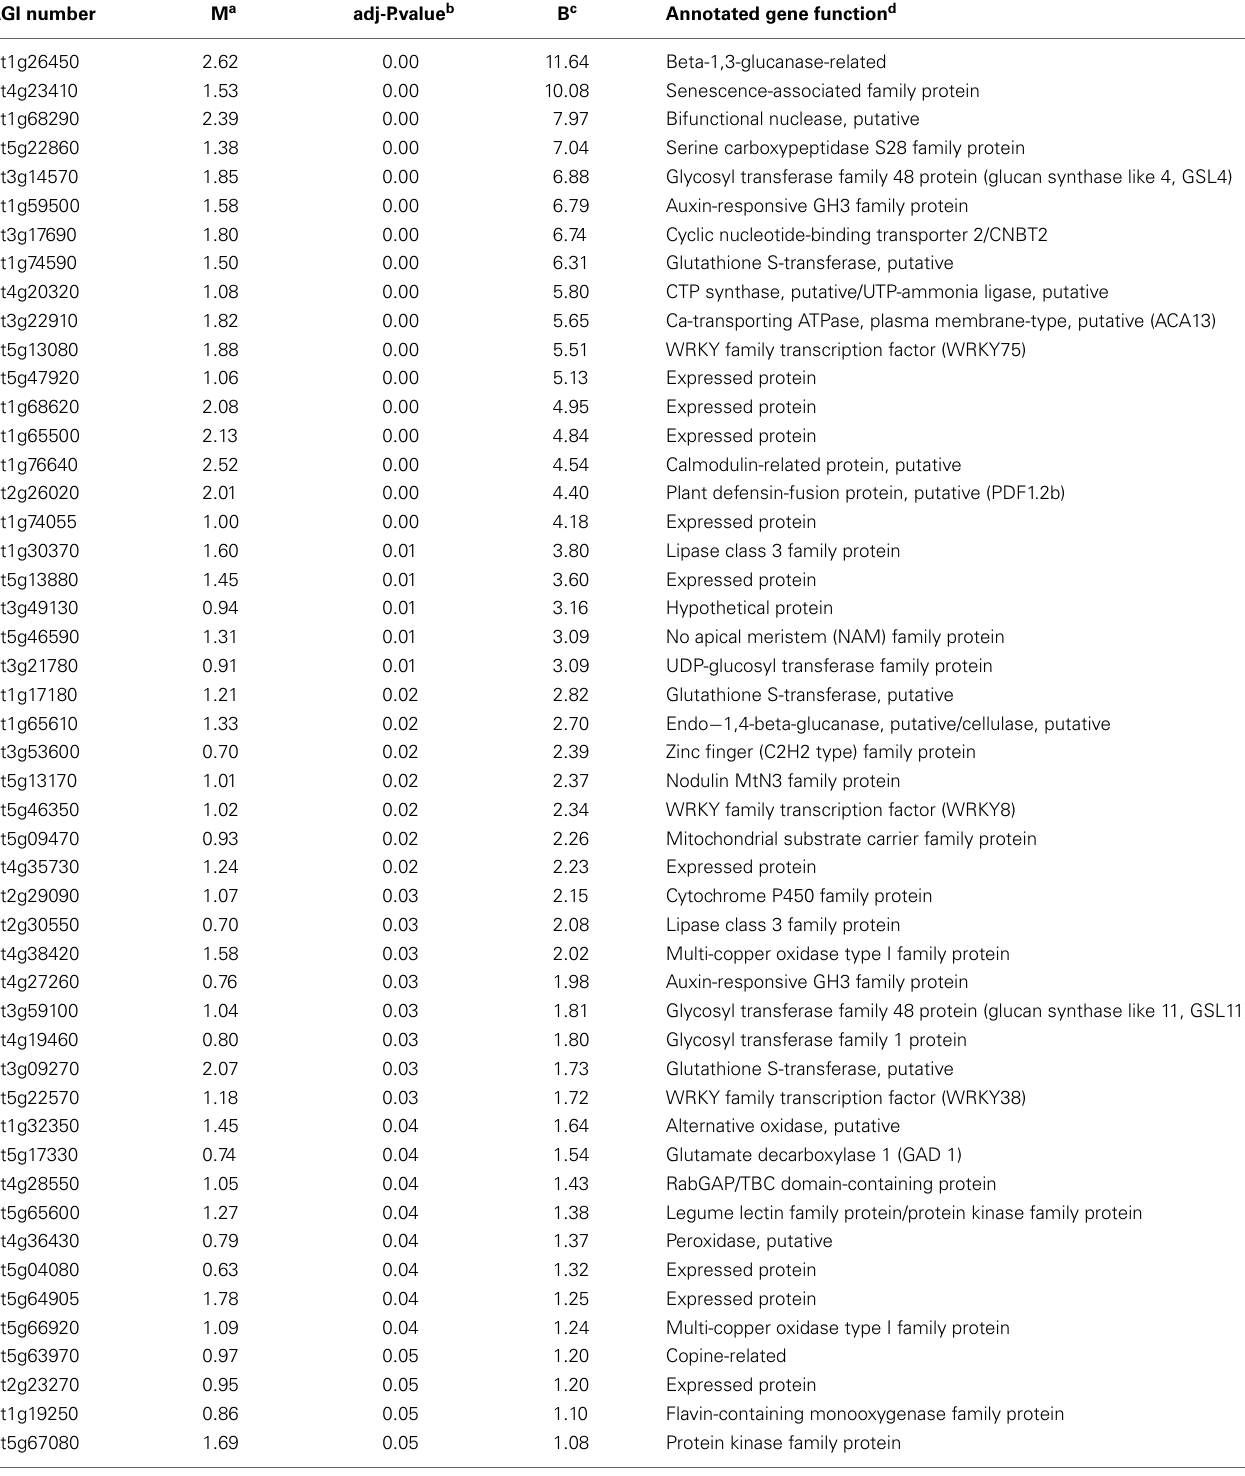
Table 1 | The 49 genes significantly upregulated in vte2 relative to Col at 48h of LT treatment. AGI